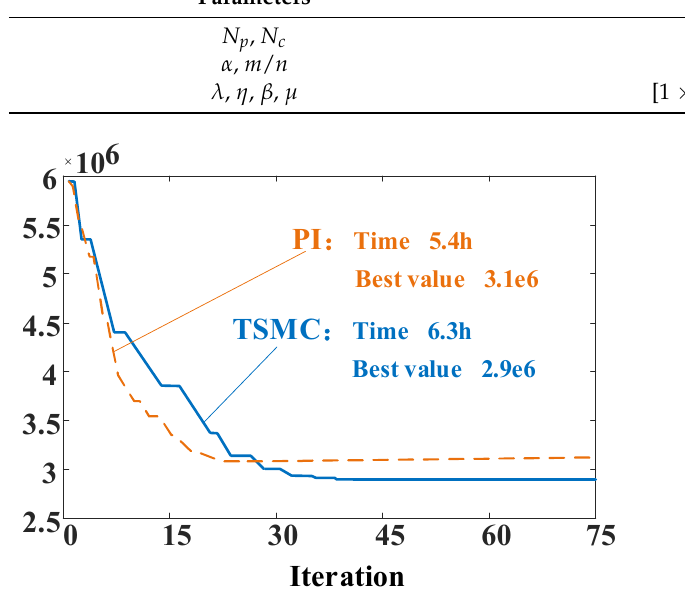
Figure 6. Optimization evolution of HWOA.